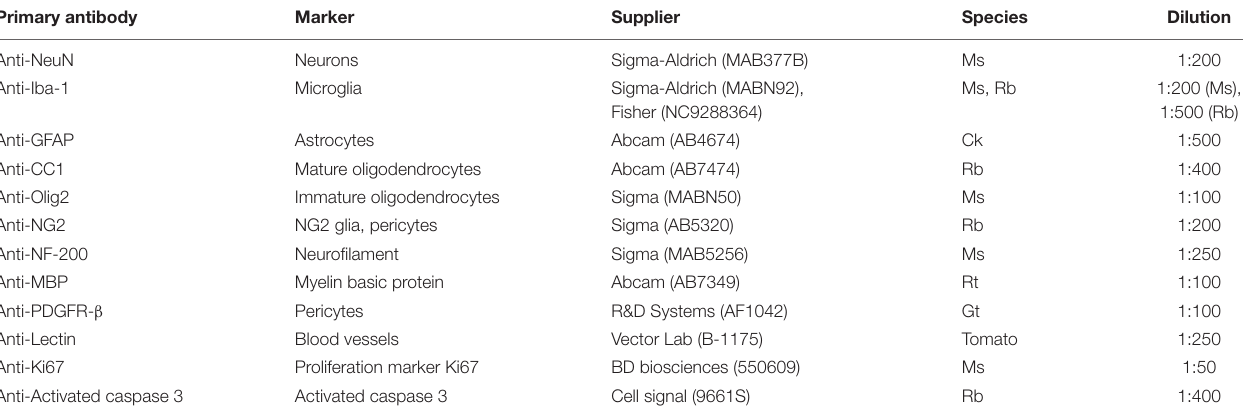
TABLE 1 | List of primary antibodies used for immunohistological